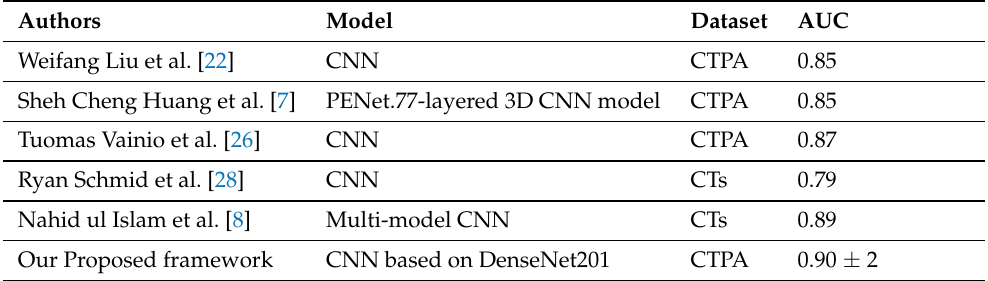
Table 3. Comparison with state of the